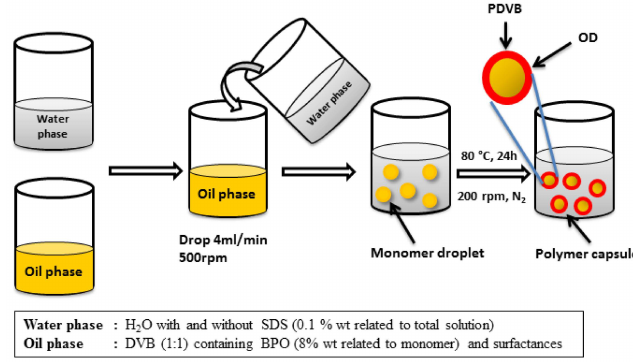
Figure 2. Microsuspension polymerization process